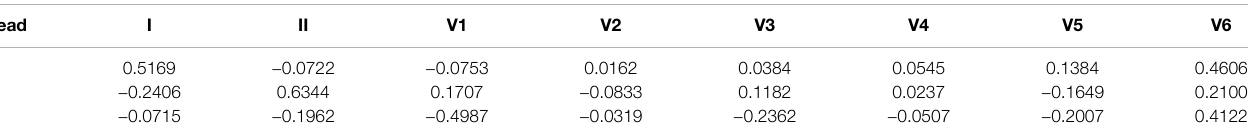
TABLE 7 | Mason – Likar transformation